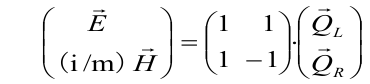
Figure 2: Backscattering intensity perturbation for ABN system versus positions of inner sphere; sizes of gold particle in nm : 40 (green), 60 (red) and 80